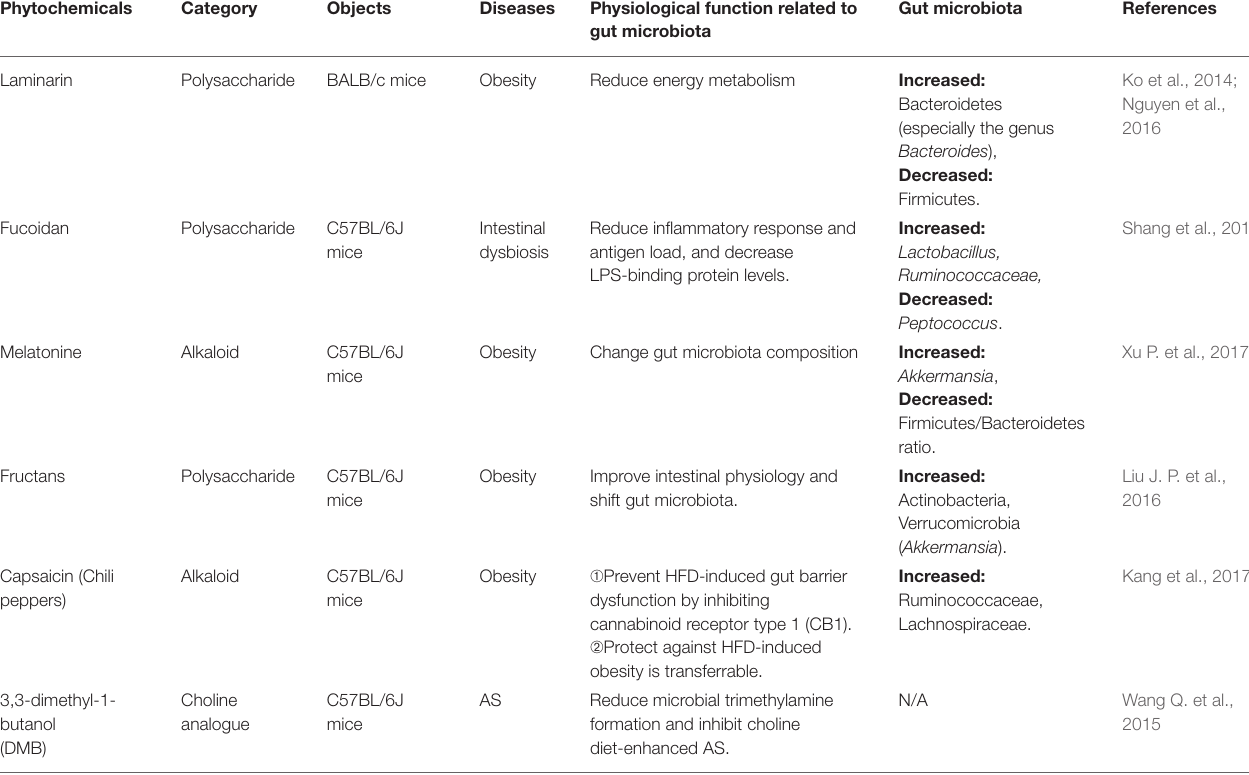
TABLE 5 | Functional food phytochemicals and gut microbiota.